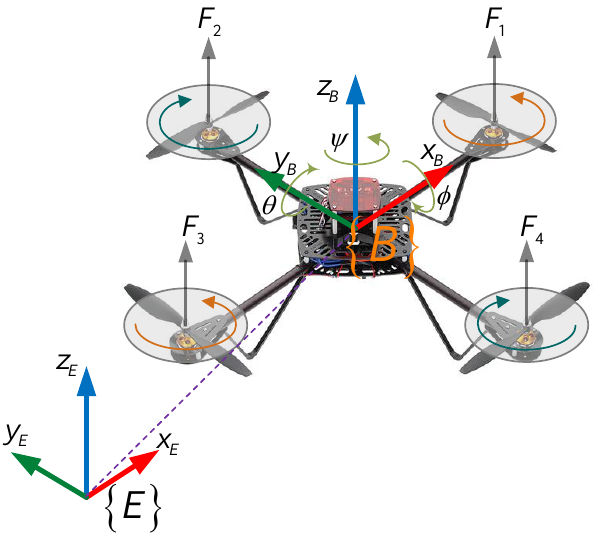
Figure 1. Quadcopter configuration. ( ) E R represent the translational and rotational transfor- B